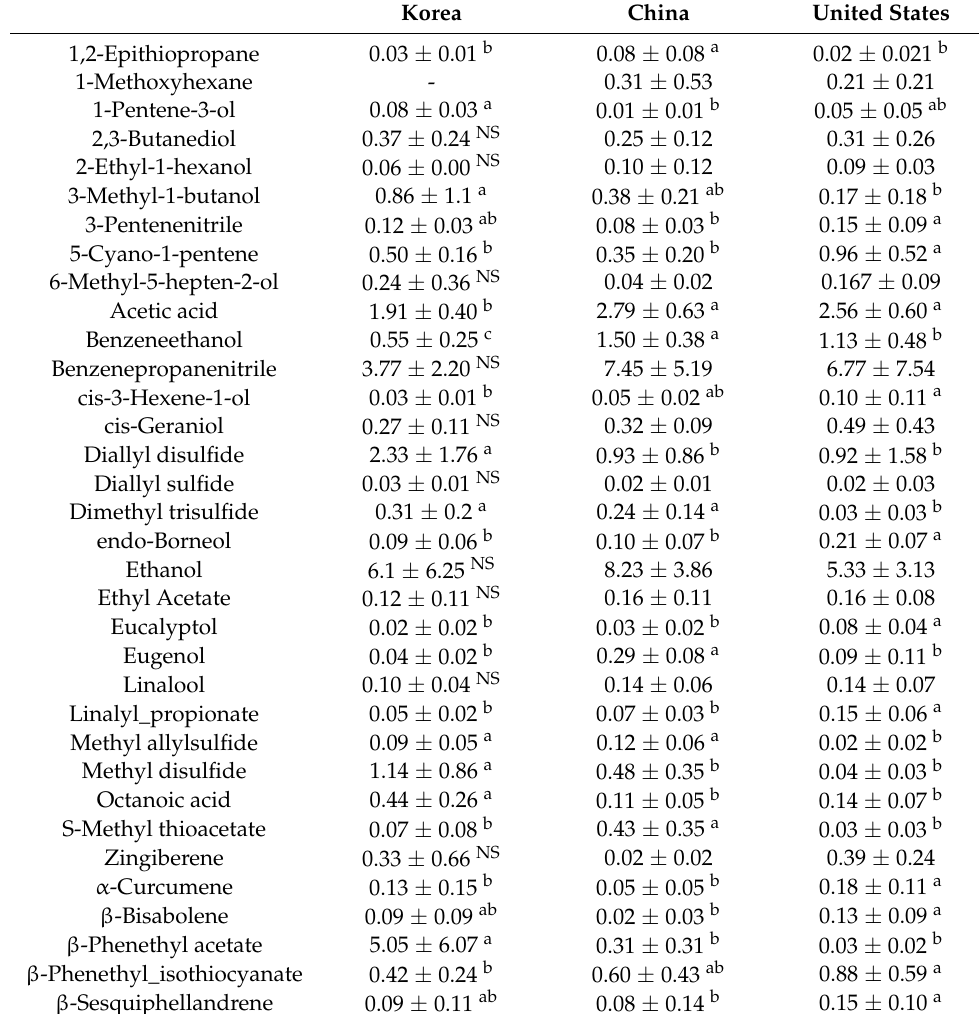
Table 6. Volatile compounds contents of commercial kimchi manufactured in Korea, China, and the United States ( µ